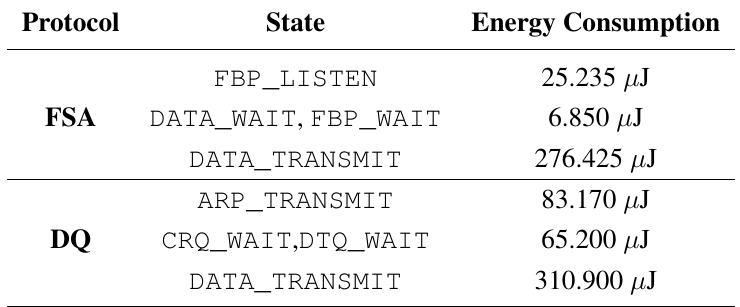
Table 4. Average energy consumption in each of the Frame Slotted ALOHA (FSA) and Distributed Queuing (DQ) states. The energy consumption in each DQ state is larger than in FSA due to listening the FBP in each slot.